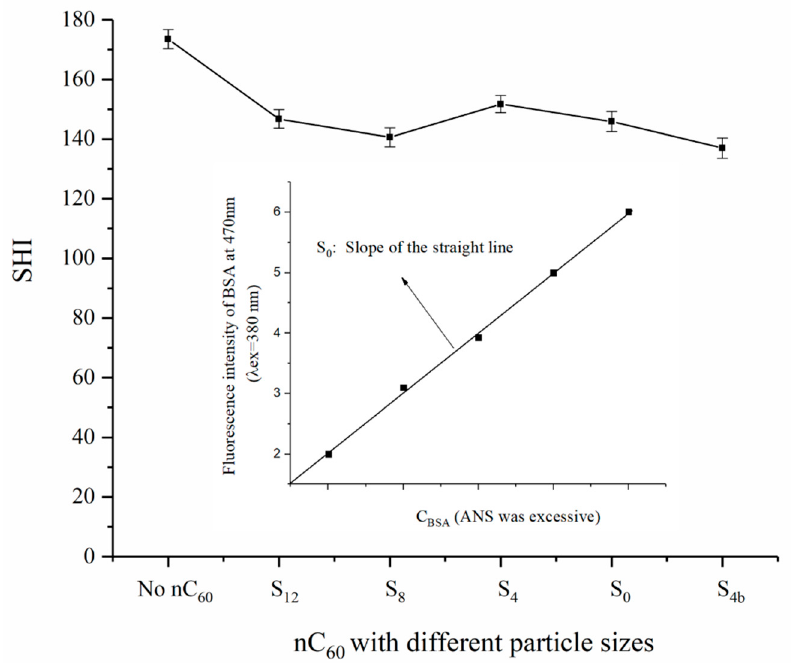
Figure 3. The BSA surface hydrophobicity determined using the ANS fluorescence probe method in the absence and presence of nC 60 nanoparticles.